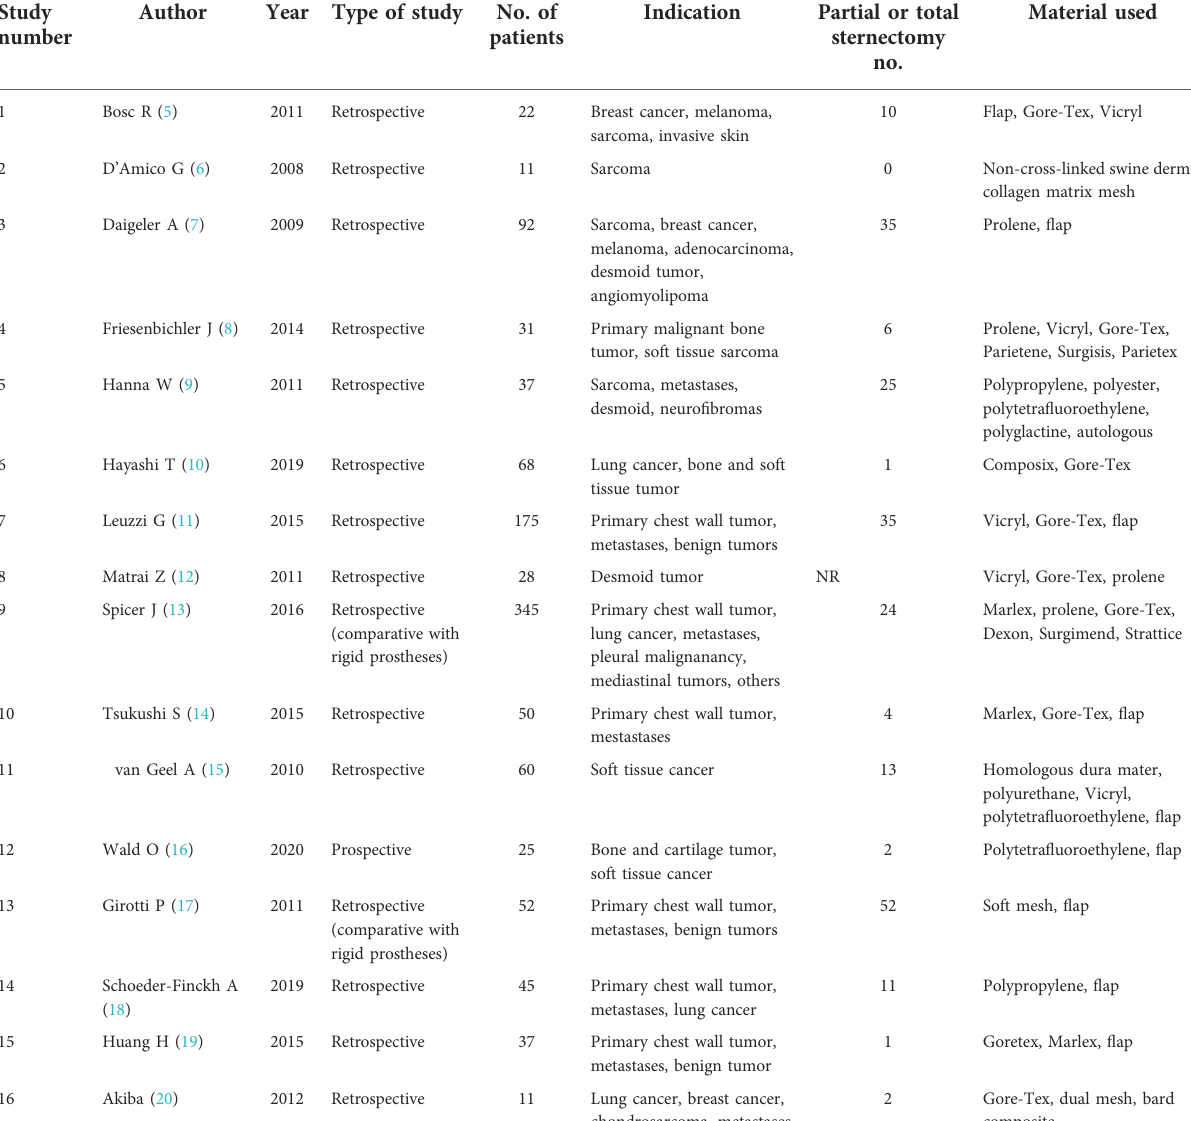
TABLE 1 Characteristics and data of the included studies